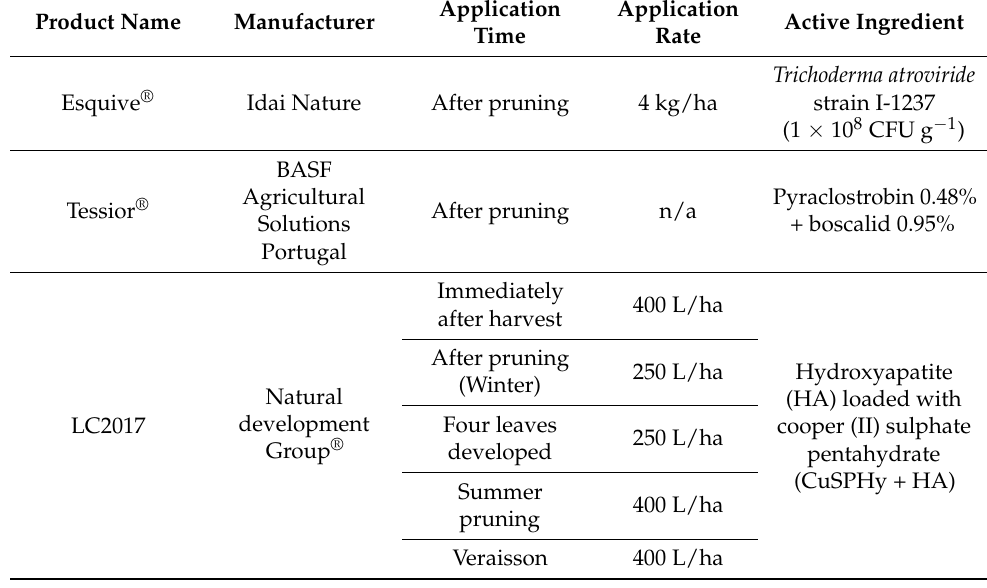
Table 4. Treatments tested for control of Lasiodiplodia theobromae and Lasiodiplodia mediterranea under field